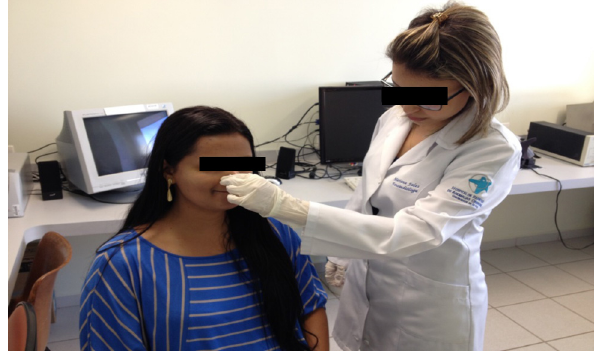
Figure 1 Performing the Test of